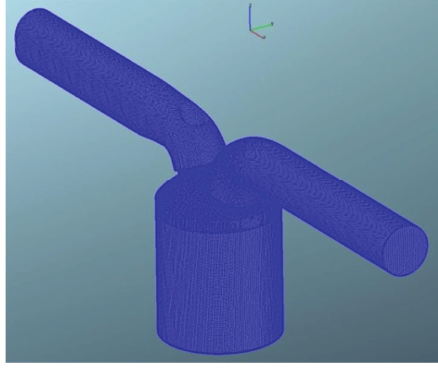
Fig. 2. Mesh model of the HCCI engine